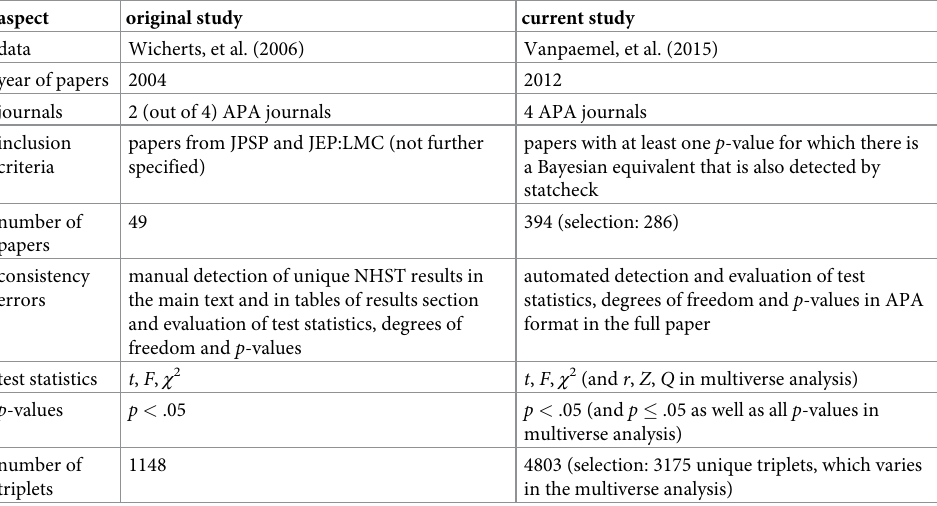
Table 5. Similarities and differences between the original study and the current